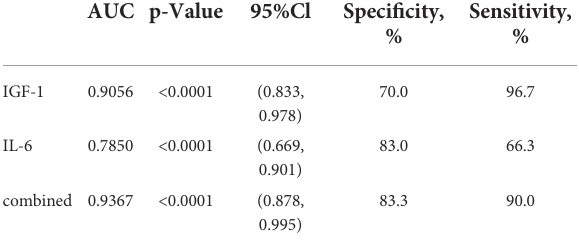
TABLE 3 Analysis of ROC curve results.